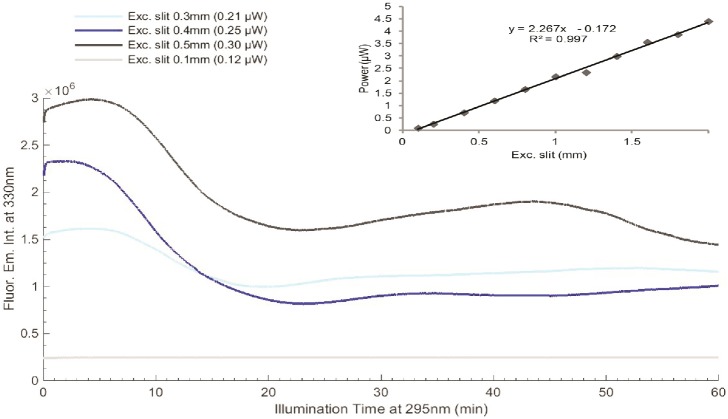
LYZ fluorescence 295 nm 2hours excitation at 20°C, using different excitation slit openings: 0.1 mm (0.1 μW), 0.3 mm (0.5 μW), 0.4 mm (0.7 μW) and 0.5 mm (1.0 μW).Fluorescence emission wavelength was fixed at 330 nm. At the upper corner is displayed the equation of the dependence of the excitation slit size (x) versus excitation power (y).